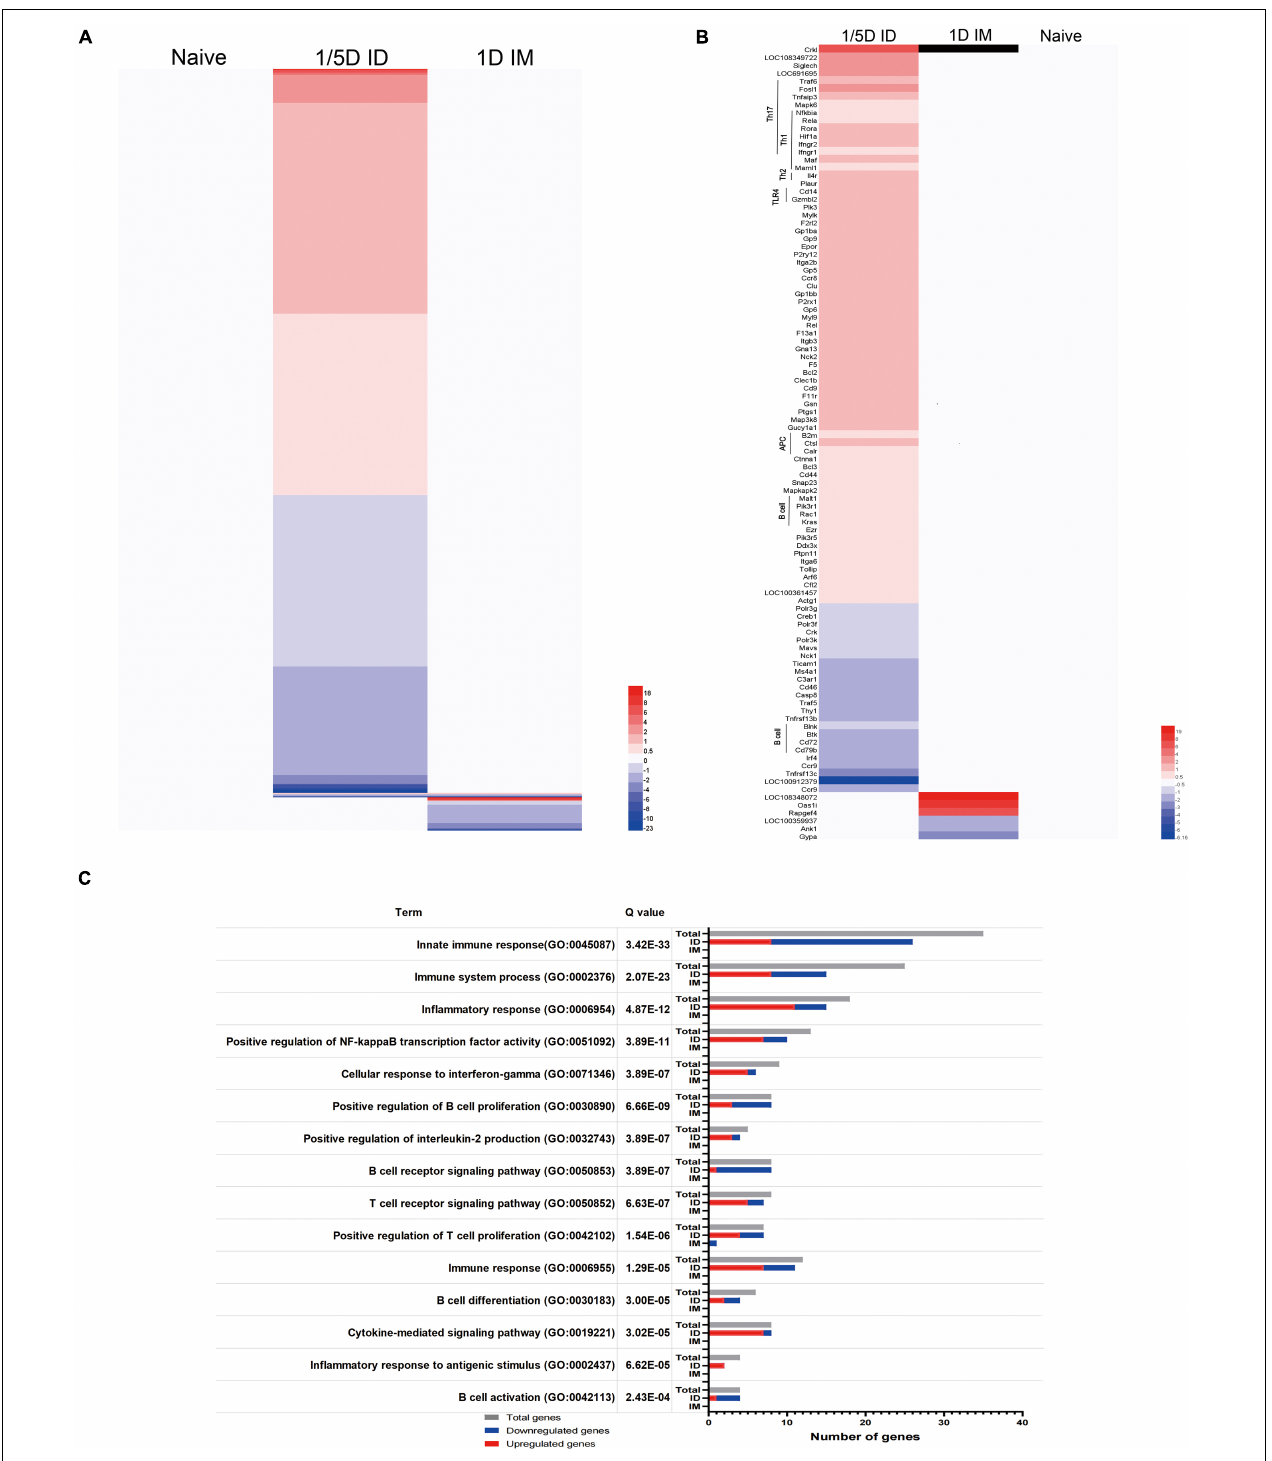
FIGURE 7 | Pulmonary transcriptomic signatures of ID or IM immunization compared with naïve rat. Gene expression in 1/5D ID and 1D IM rats was compared with naive rats [fold ratio (FR) > 1.5, Q value < 0.05, corrected by the Bonferroni test]. (A) A total of 1,026 genes upregulated (red) or downregulated (blue) are visualized in heatmaps (mean of n = 3). Genes not surpassing a fold change of 1.5 are shown as basal level (white). (B) Immune related genes, including association with distinct T helper (Th) subsets, Toll like receptor (TLR), antigen presenting cells (APC) and B cell response. (C) Over-representation analysis on all 1,026 genes revealed the involvement of specific Gene Ontology Biological Process (GO-BP) terms with corresponding total amount of genes (gray) and upregulated (red) and downregulated (blue) genes.